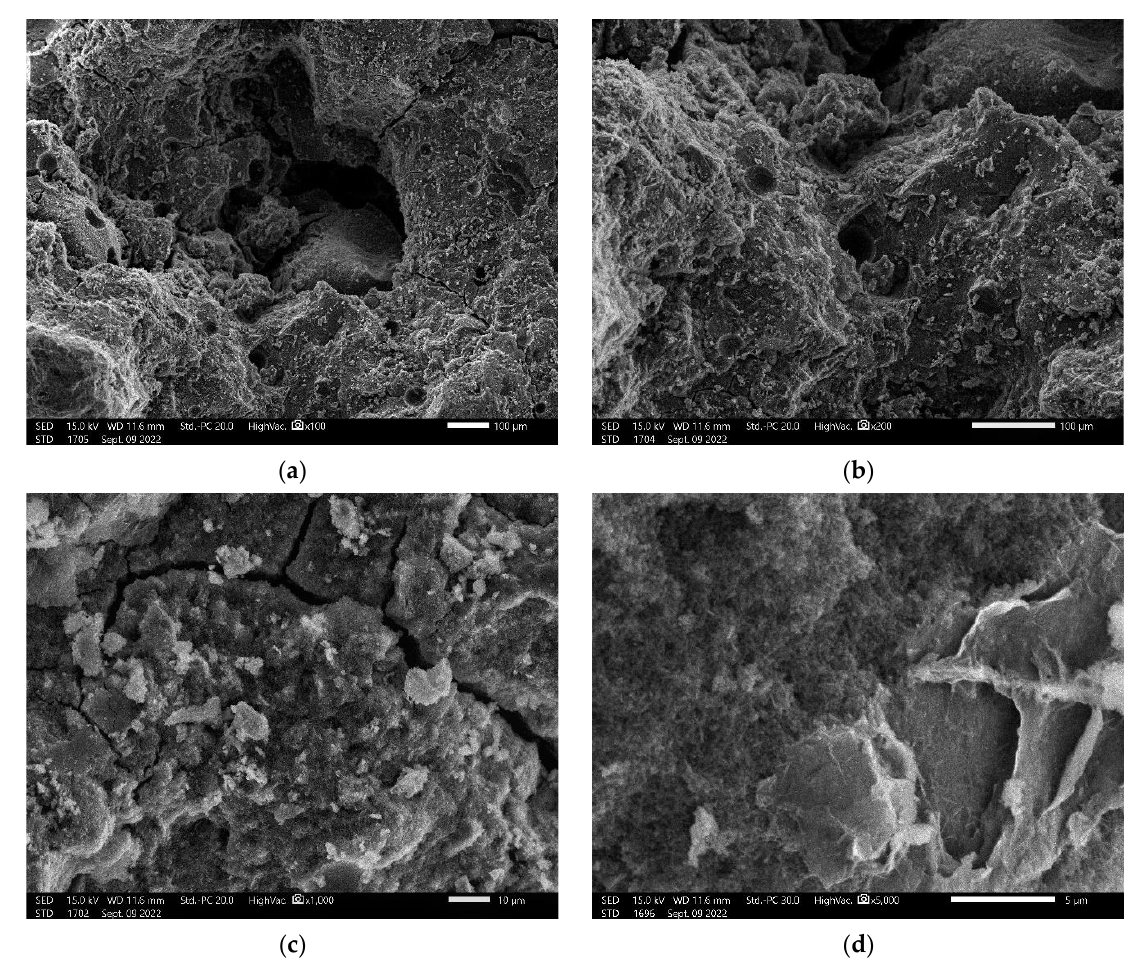
Figure 4. SEM images of geopolymer: ( a ) at 100× magnification; ( b ) at 200× magnification; ( c ) at 1000× magnification; and ( d ) at 2000× magnification.